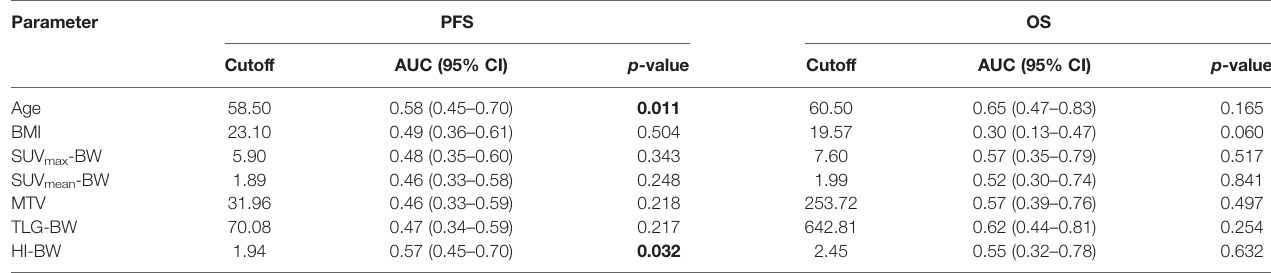
TABLE 2 | ROC curve analyses of prognostic factors for PFS and OS in MCL. Parameter